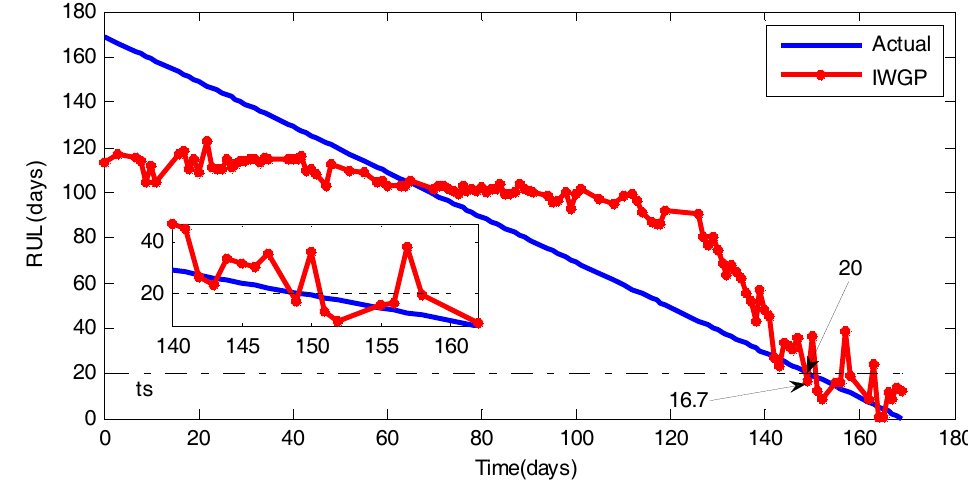
Figure 16. The prediction accuracy with IWGP method.